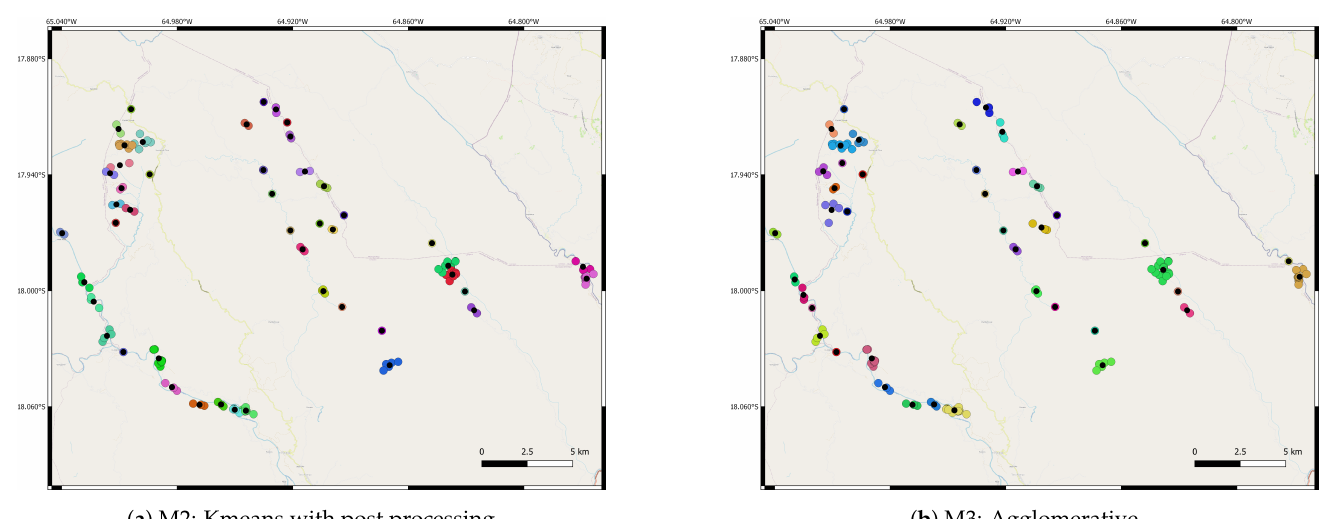
Figure 7. Results of clustering procedures in